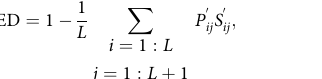
Fig. 6 Performance comparison of all predictors on 6 recently released (after March 9, 2019) crystal structures. a F1 score of predicted structure on a synthetic construct RNA (chain H in PDB ID 6dvk), b F1 score of predicted structure on the Glutamine II Riboswitch RNA (chain A in PDB ID 6qn3), c F1 score of predicted structure on a synthetic construct Hatchet Ribozyme (chain U in PDB ID 6jq6), d F1 score of predicted structure on a Pistol Ribozyme (chain A & B in PDB ID 6r47), e F1 score of predicted structure on the Mango Aptamer (chain B in PDB ID 6e8u), f F1 score of predicted structure on the adenovirus virus-associated RNA (chain C in PDB ID